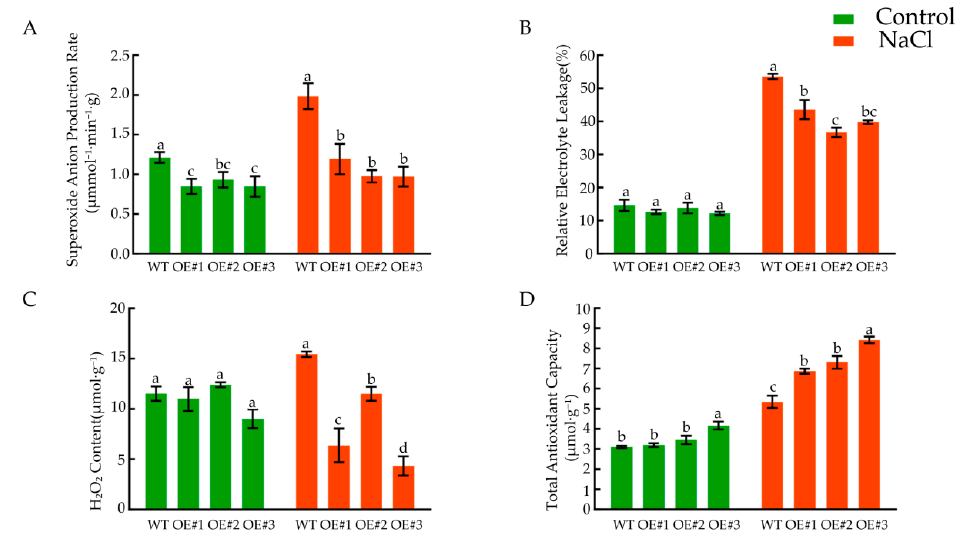
Figure 14. Effects of salt stress on the physiological indices of the seedlings. ( A ) Superoxide anion production rate. ( B ) Relative electrolyte leakage. ( C ) H 2 O 2 content. ( D ) Total antioxidant capacity. Bars with different letters “a, b, c, d” above the columns indicate significant differences ( p < 0.05, Duncan’s range test) on a given day of treatment.